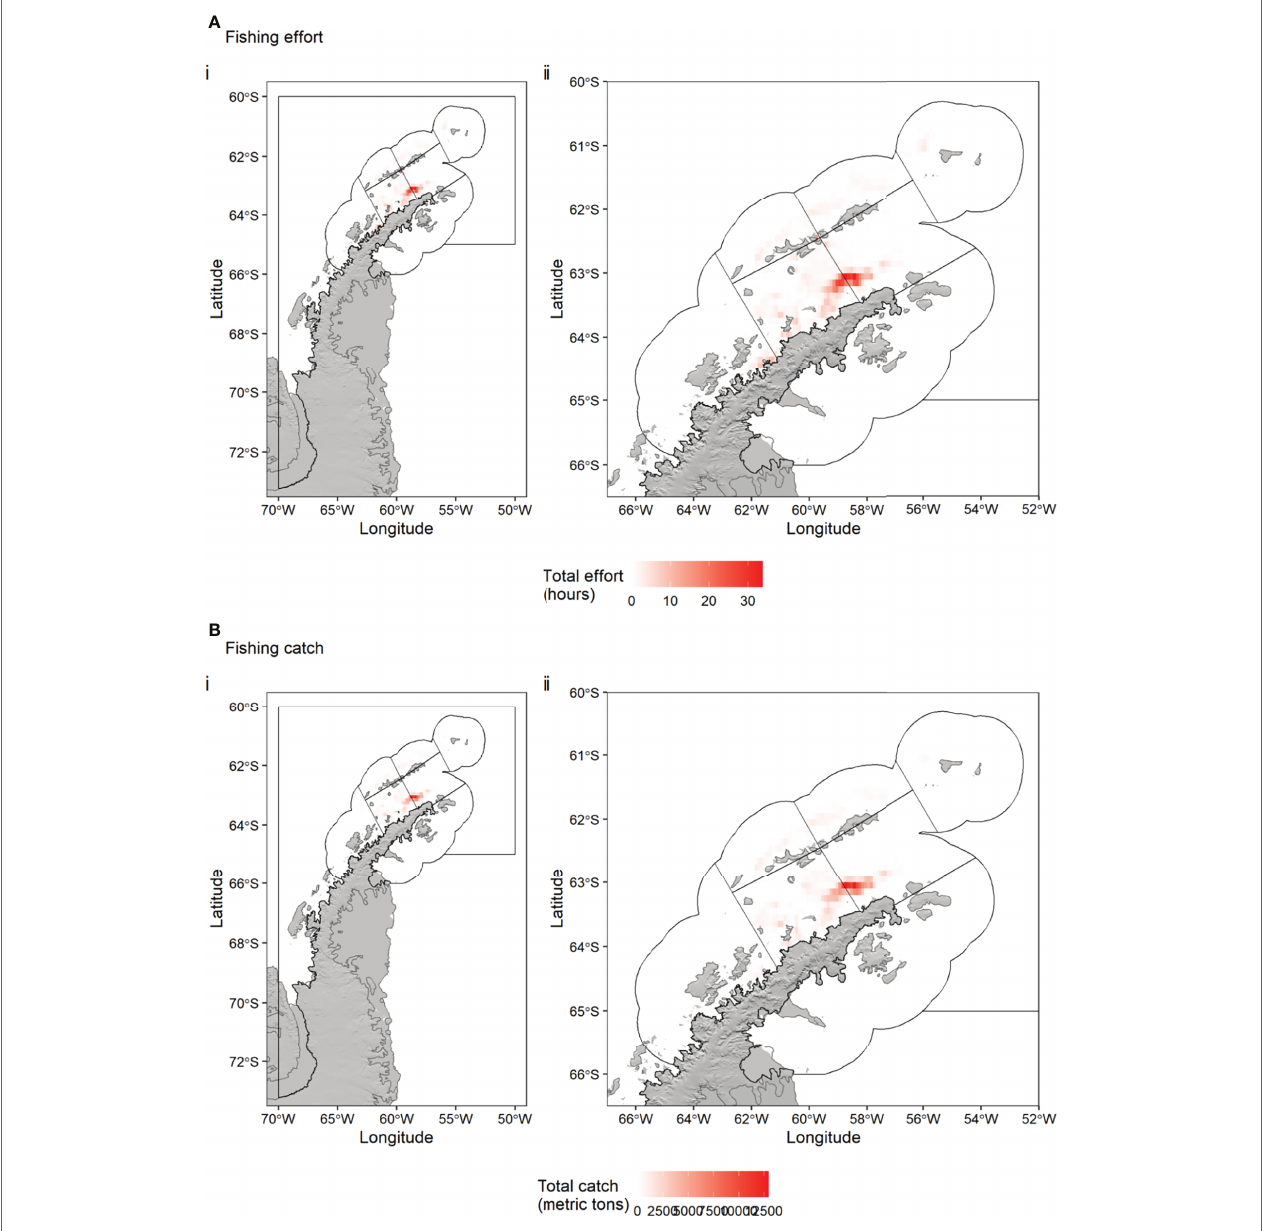
FIGURE 5 | Total Antarctic krill fishing effort (hours) (A) and catch (tonnes) (B) per 0.1° x 0.1° grid cell in statistical subarea 48.1 over the period December 2015 – May 2020. Black polygons indicate the seven Small Scale Management Units (SSMUs) within the Subarea, named in Figure 1 . Catch data: CCAMLR. Effort data: Global Fishing